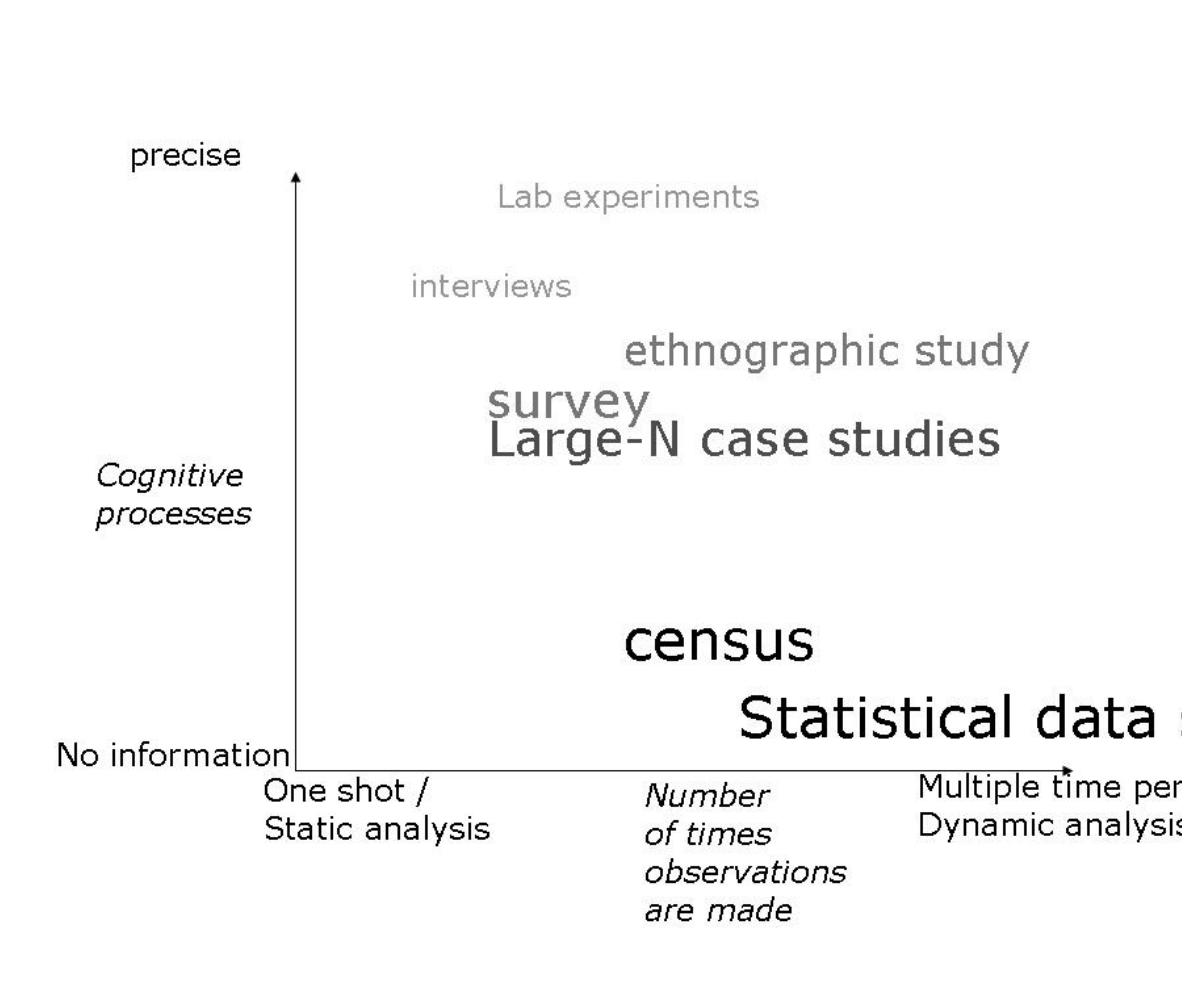
Fig. 1. Different empirical techniques depicted on the axes of number of times observations are made and cognitive processes. The third axis is the number of people involved; the larger and darker the fonts, the more people are